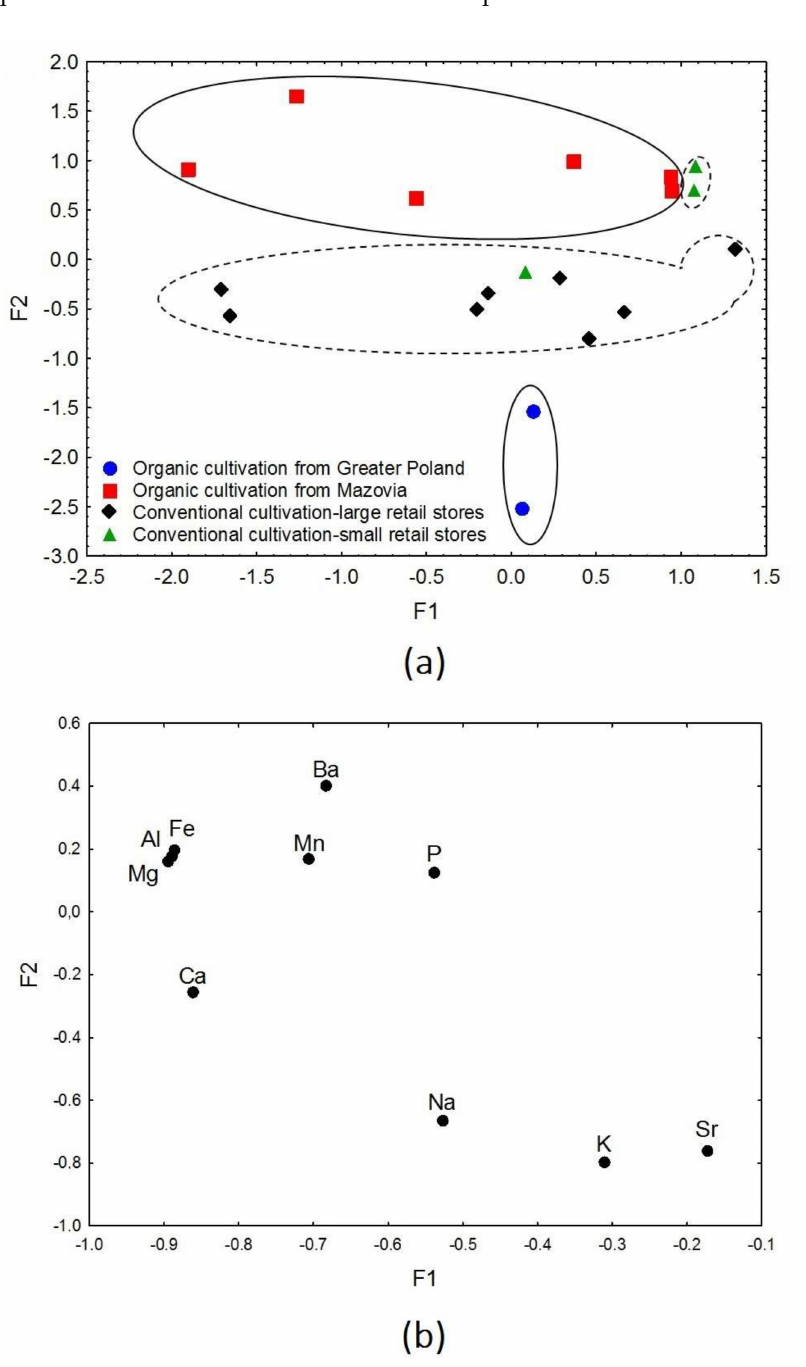
Figure 5. ( a ) Scatter plot of object samples of two factors for the beetroot samples. ( b ) Scatter plot of loading for elements in all the analysed